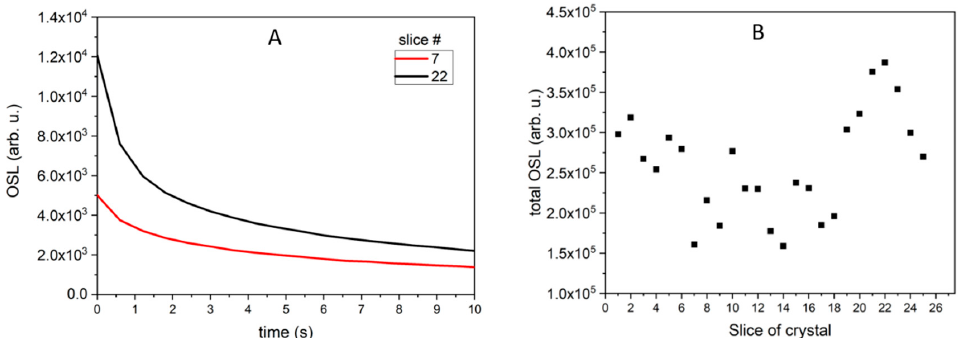
Figure 5. OSL signal of LMP doped with 0.8-mol% Tm and 10-mol% B. ( A )—OSL decay curves for slices #7 and #22. ( B )—total OSL signals integrated from 0 to 300 s for all OSL curves. The samples were irradiated with 0.2 Gy of beta rays in a Risø reader. Slice of crystal—the numbers represent labelling of samples along the crystal length, as illustrated in Figure 1.